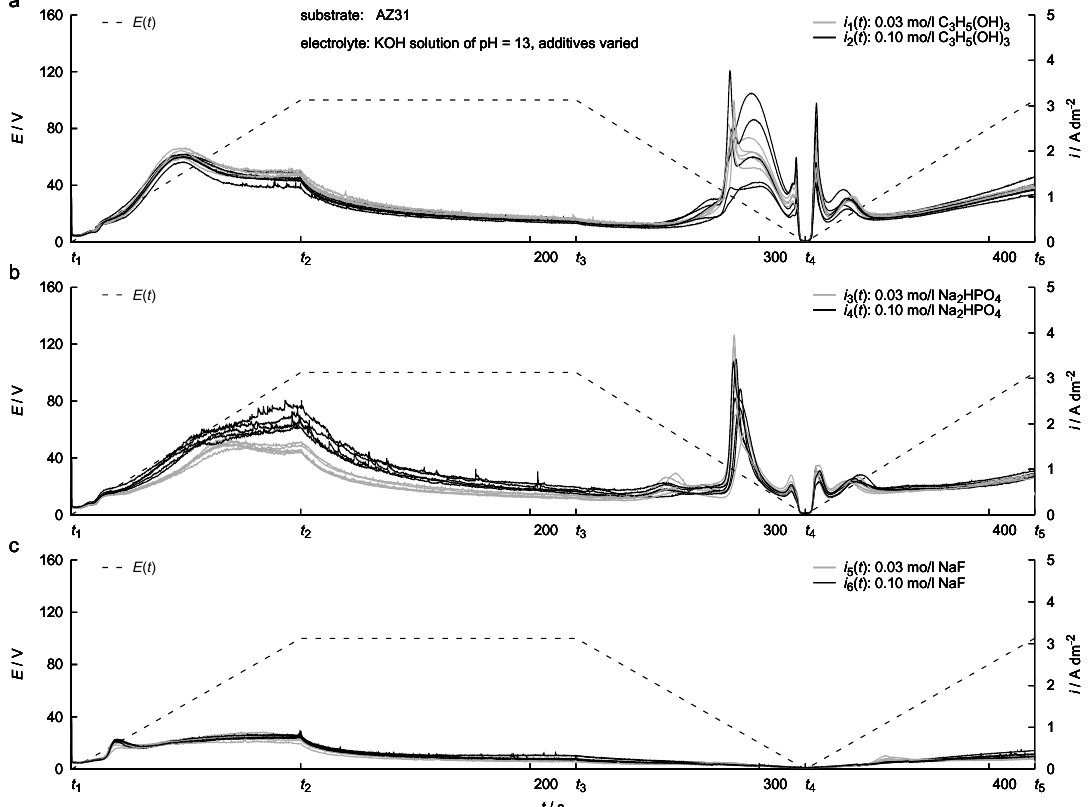
Figure 8. Results of polarisation experiments within KOH solution of pH = 13 with various electrolyte additives, the curves for five repetitions of each measurement are shown. Table 3 lists the electrical conductivities of the electrolytes